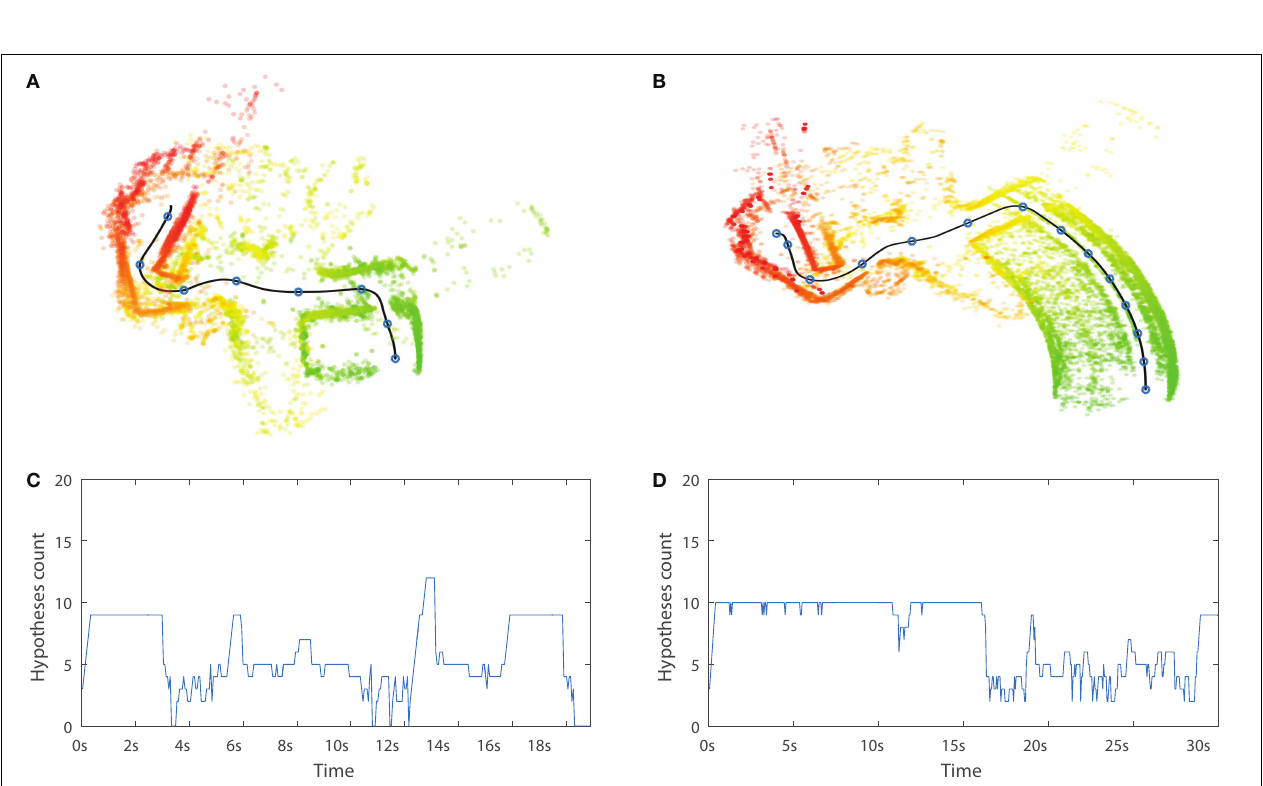
FIGURE 10 | Typical runs from condition Storage to TV . Upper plots present laser scans in relation to the executed path, generated during overt (A) and covert (B) runs from storage room (green) to TV (red). Blue circles along the path, represented by the black line, mark 2.5-s intervals. Lower plots present number of matching hypotheses over time, for overt (C) and covert (D) runs. See text for details.